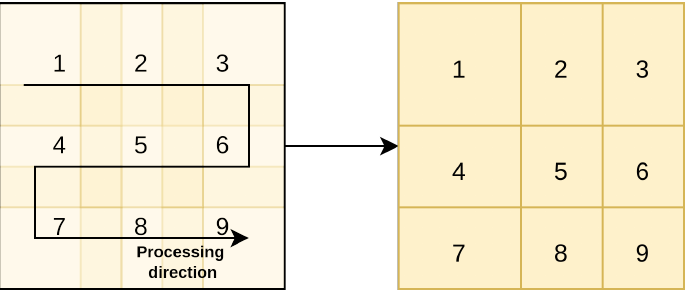
Figure 9. Multi-tiling covers the computation of new unique pixels. Notice how the tiles on the right cover the pixels covered for the first by the tiles on the left. The multiple tiles are ordered following a left-to-right and top-to-bottom order, rather than the processing direction to avoid additional irregularities in the